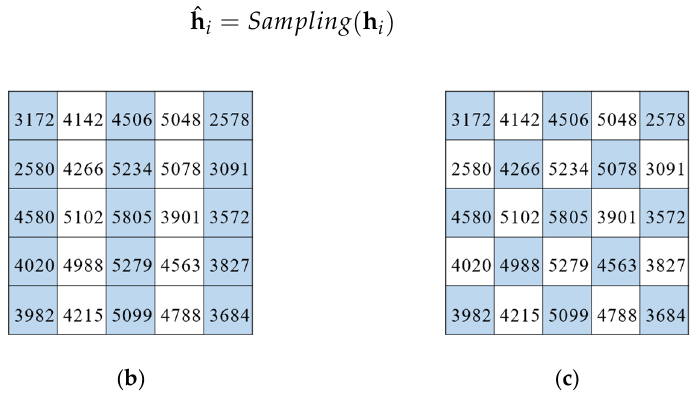
Figure 2. Sampling strategies. ( a ) Row sampling; ( b ) column sampling; ( c ) cross sampling.